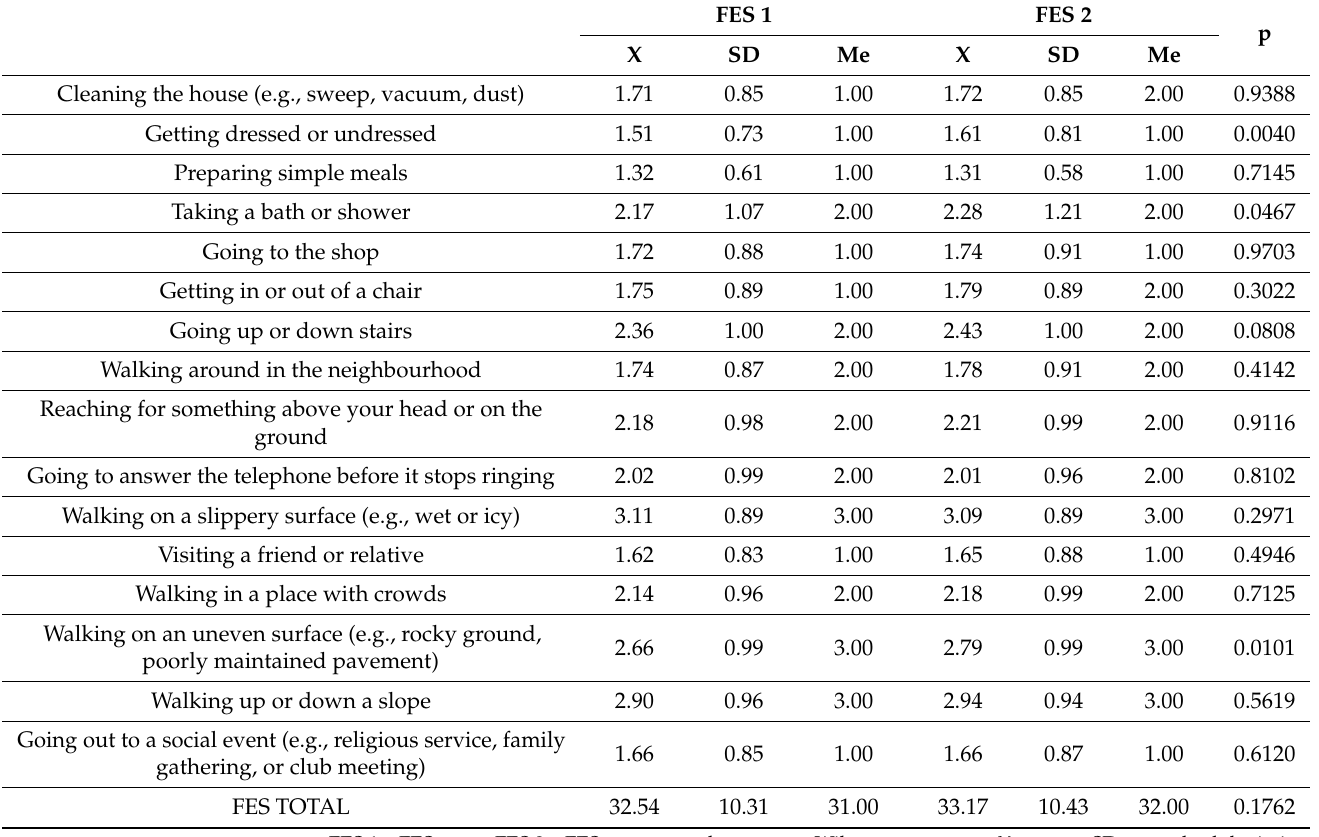
Table 3. Repeatability check, respondents’ responses one week